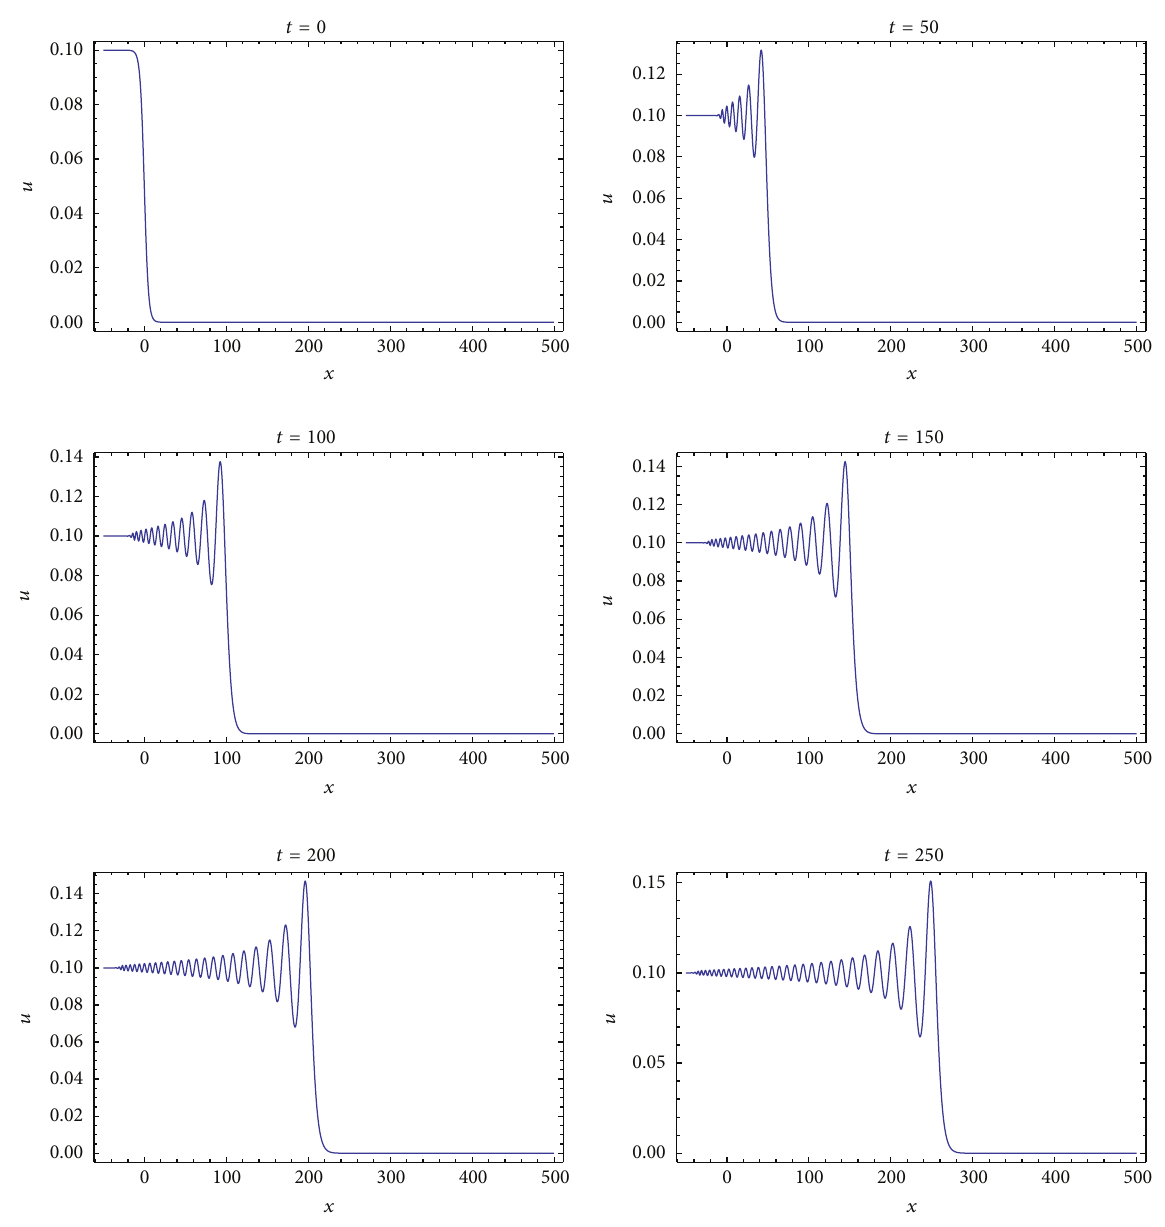
Figure 8: Evolution of initial undular bore (59), where 𝑢 0 = 0.1 , 𝑥 0 = 0 , and 𝛼 = 2 for Δ𝑡 = 0.001 and 𝑛 = 2500 on the interval 𝑥 ∈ [−50, 500] using the nonstandard finite difference scheme (40).